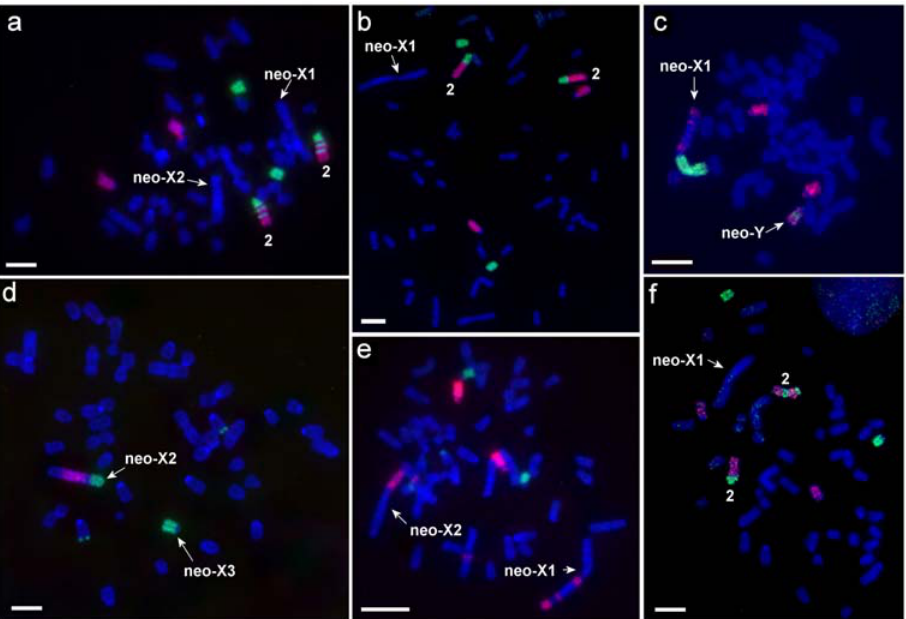
Figure 2. Examples of fluorescent in situ hybridization: ( a ) MAG5 (green) and MAG1 (red) onto LMAN1f, ( b ) MAG5 (green) and MAG1 (red) onto LMAN10m, ( c ) MAGX (green) and MAG13 + 14 (red) onto LMAN10m, ( d ) MAG17 (green) and MAGX (red) onto LMAN6f, ( e ) MAG23 (green) and MAG13 + 14 (red) onto LMAN1f, ( f ) MAG1 (red) and MAG5 (green) onto LMAN15m. Scale bar is 10 µ m.